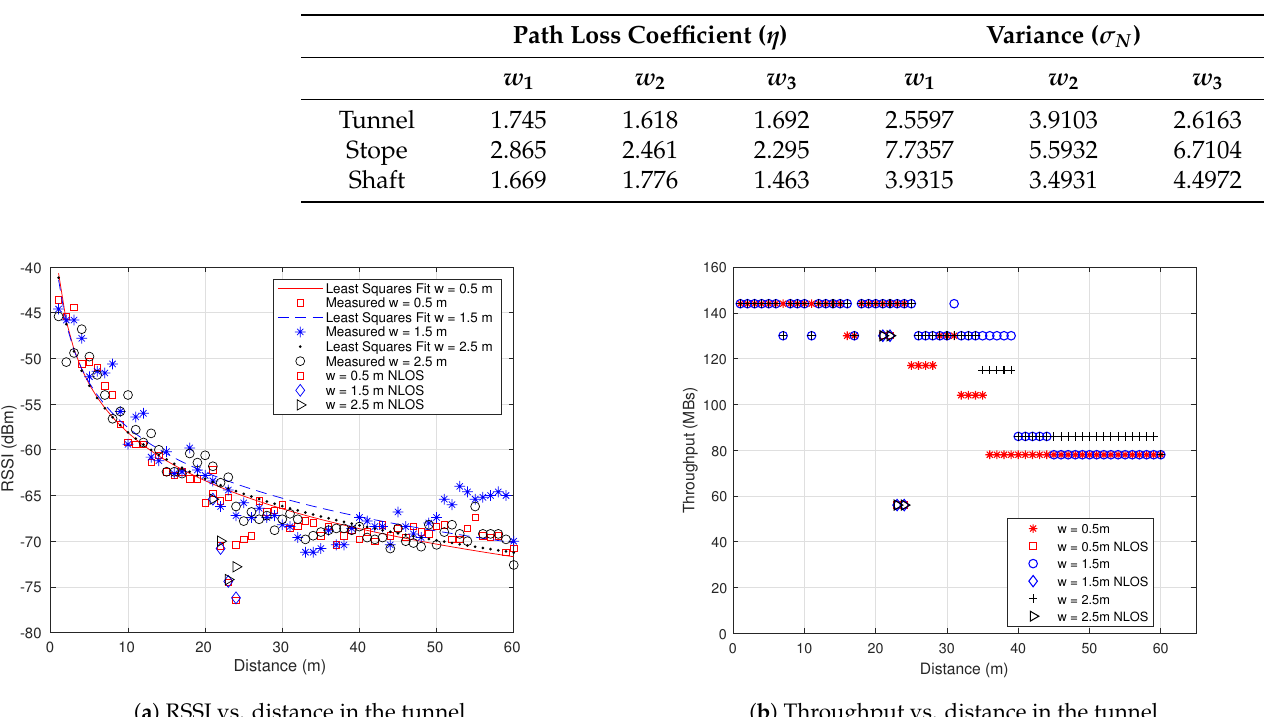
Table 2. Dimensions of experimental environments.